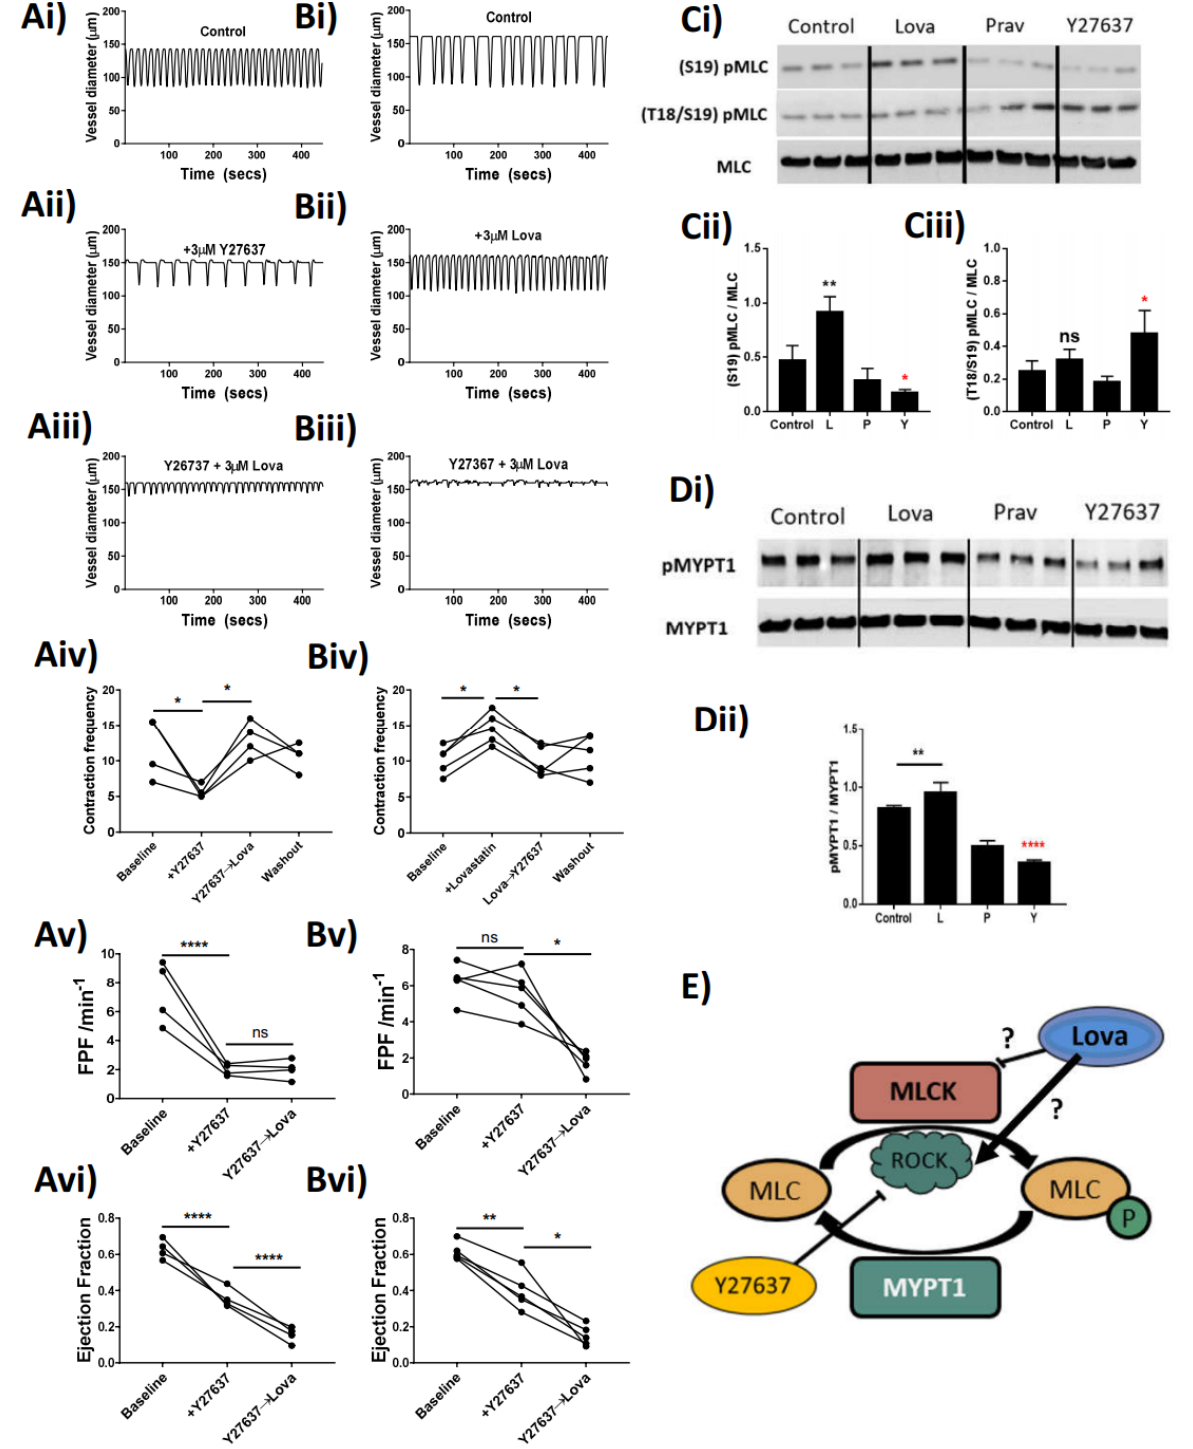
Figure 5. Lovastatin modulates the effect of RhoKinase inhibitor Y27637 in rat mesenteric collecting lymphatic vessels and isolated smooth muscle cells. Isolated and pressurized rat mesenteric lymphatic vessels were ( Ai , Bi ) baseline control, pre-incubated with either ( Aii ) 3 µ M Y27637 or ( Bii ) 3 µ M Lovastatin for 20 min before being co-incubated with ( Aiii ) 3 µ M Lovastatin or ( Biii ) 3 µ M Y27637. ( Aiv , Biv ) Vessel contractility frequency changes in response to treatments were assessed over a 5 min period after the addition of each mentioned drug. ( Av , Avi , Bv , Bvi ) Changes in Fractional pump flow (FPF) or Ejection fraction of individual vessels after addition of each drug. Primary isolated rat collecting lymphatic smooth